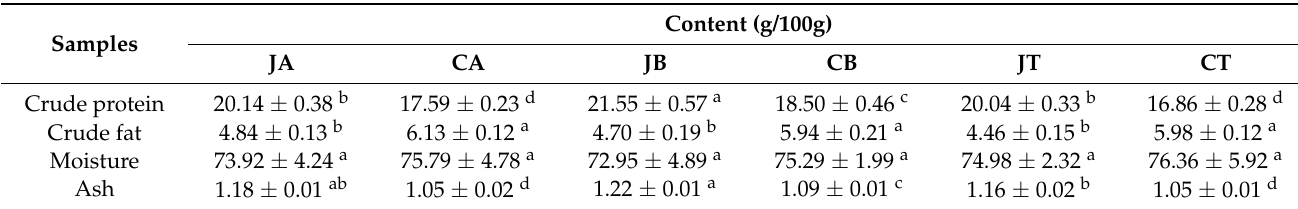
Table 1. Comparison of physicochemical parameters in different parts of JPGC and CGC.